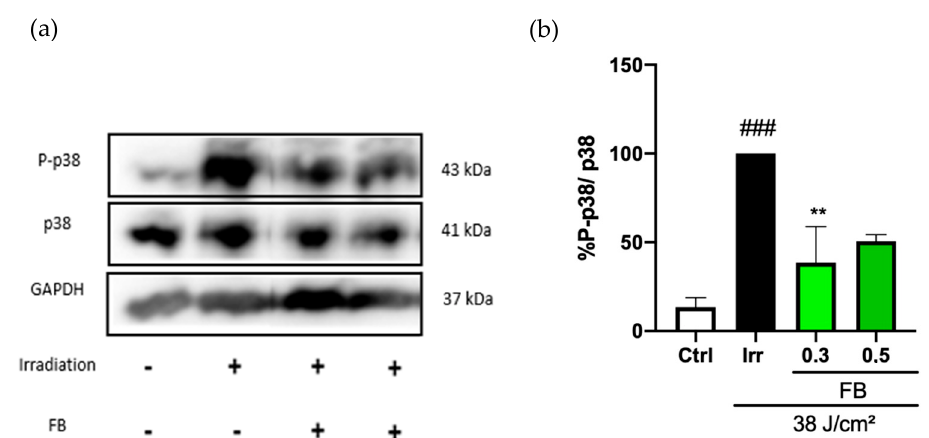
Figure 4. Phosphorylation of p38 in HDF exposed to artificial blue light. Phosphorylation of p38 was evaluated by Western blot ( n = 3). Cells were incubated in phenol red-free Dulbecco’s modified eagle medium (DMEM) 0% fetal bovine serum (FBS), treated for 24 h with FB (concentrations), irradiated with blue light (38 J/cm 2 ) and proteins extracted 1 h post-irradiation. Representative immunoblots ( a ) and their quantification plot ( b ) are shown. Data are expressed as % of non-irradiated cells. Data are shown as mean ± SEM. ### p < 0.001 vs control cells and ** p < 0.01 vs the corresponding irradiated (Irr) cells.